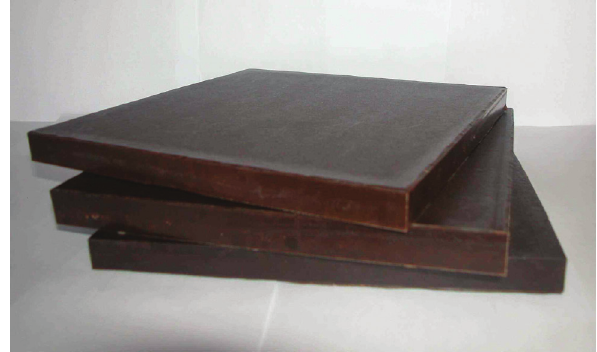
Figure 2 Density of the flat-pressed panels (mean values with 95% confidence intervals are